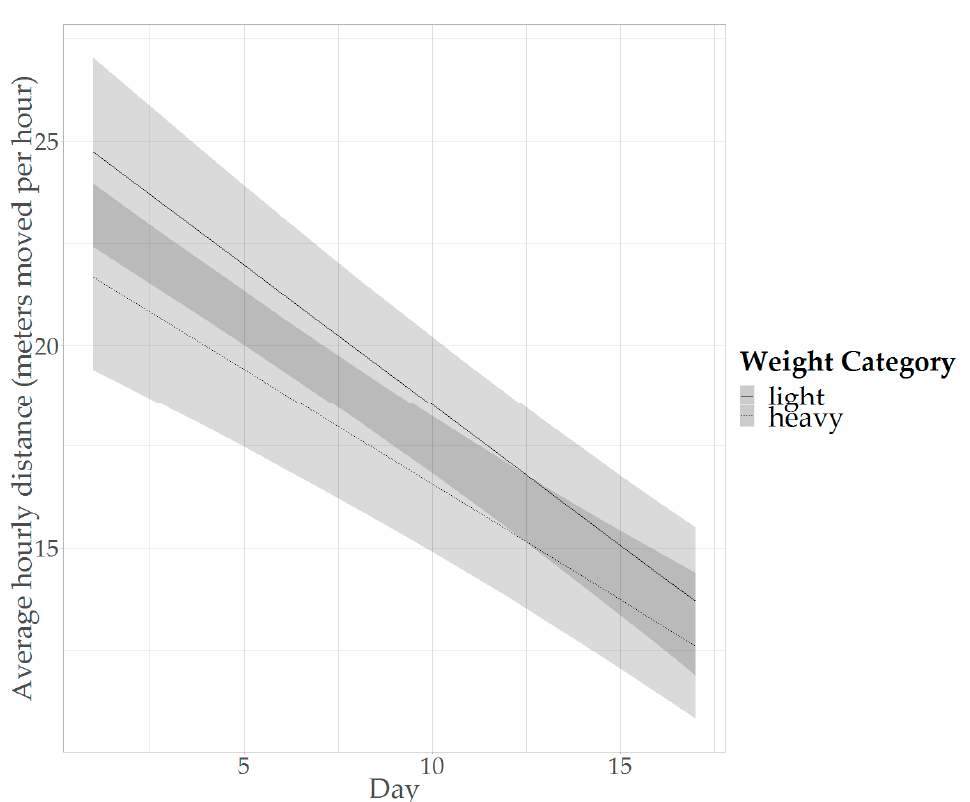
Figure 3. Predicted activity over the tracking period (day 1 to 17 of tracking, corresponding to day 16 to 32 of life) in the activity model, distinguishing between the different weight categories. Shaded areas represent 95% CIs.